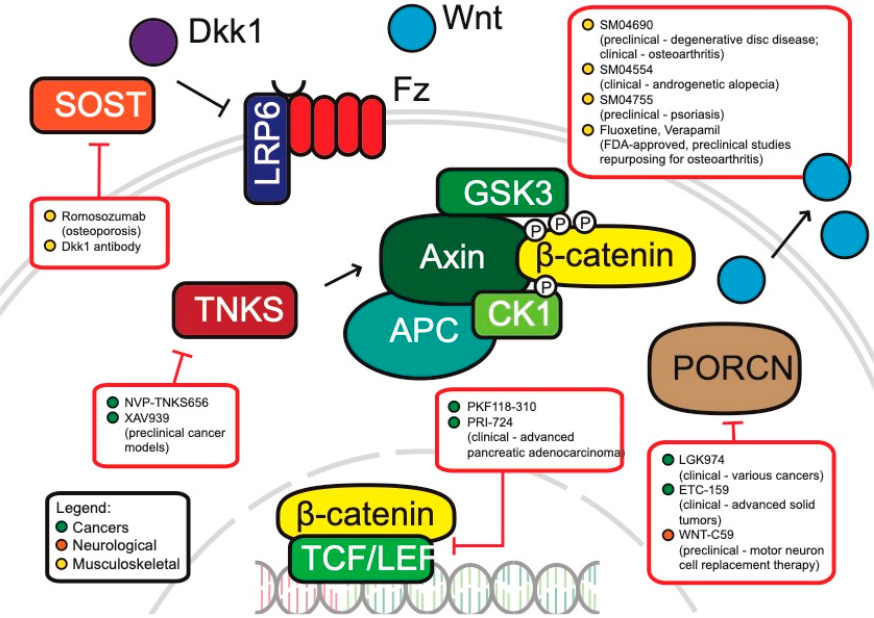
Figure 4. Drugs developed against canonical WNT pathway components. SOST, Sclerostin; PORCN, porcupine; TNKS, Tankyrase.